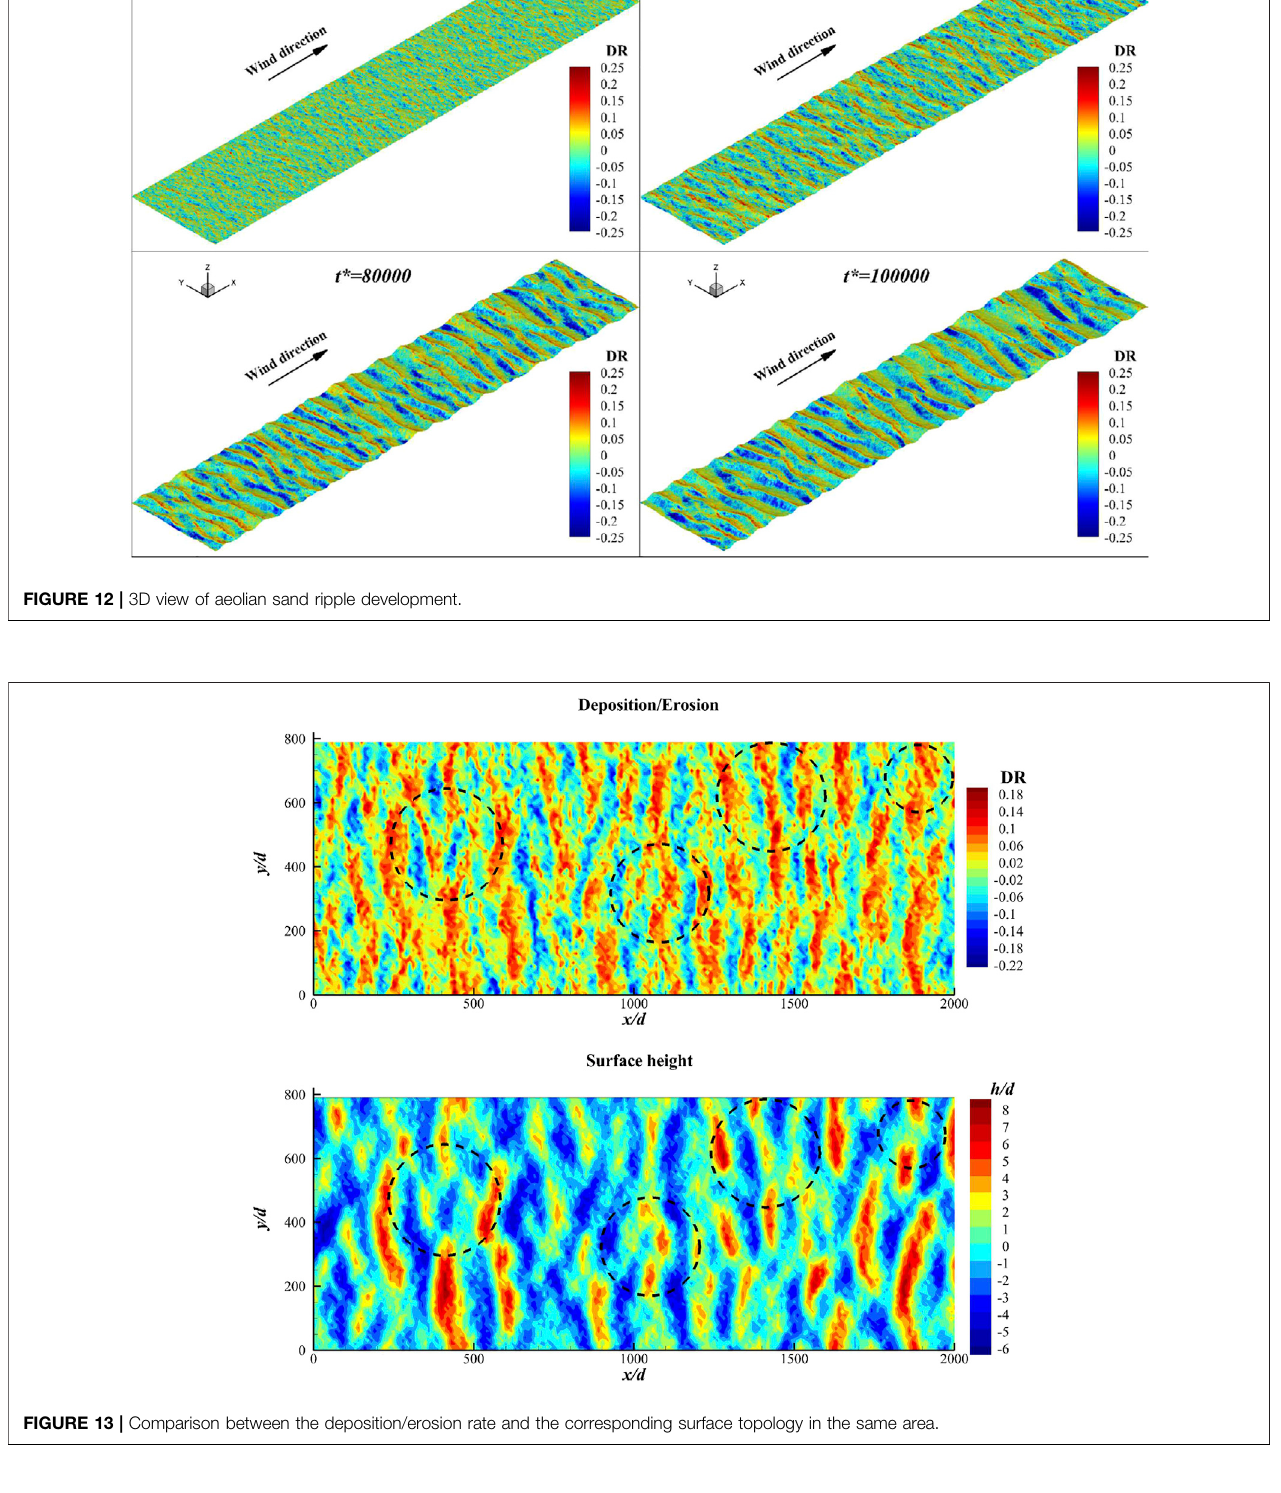
Frontiers in Physics |